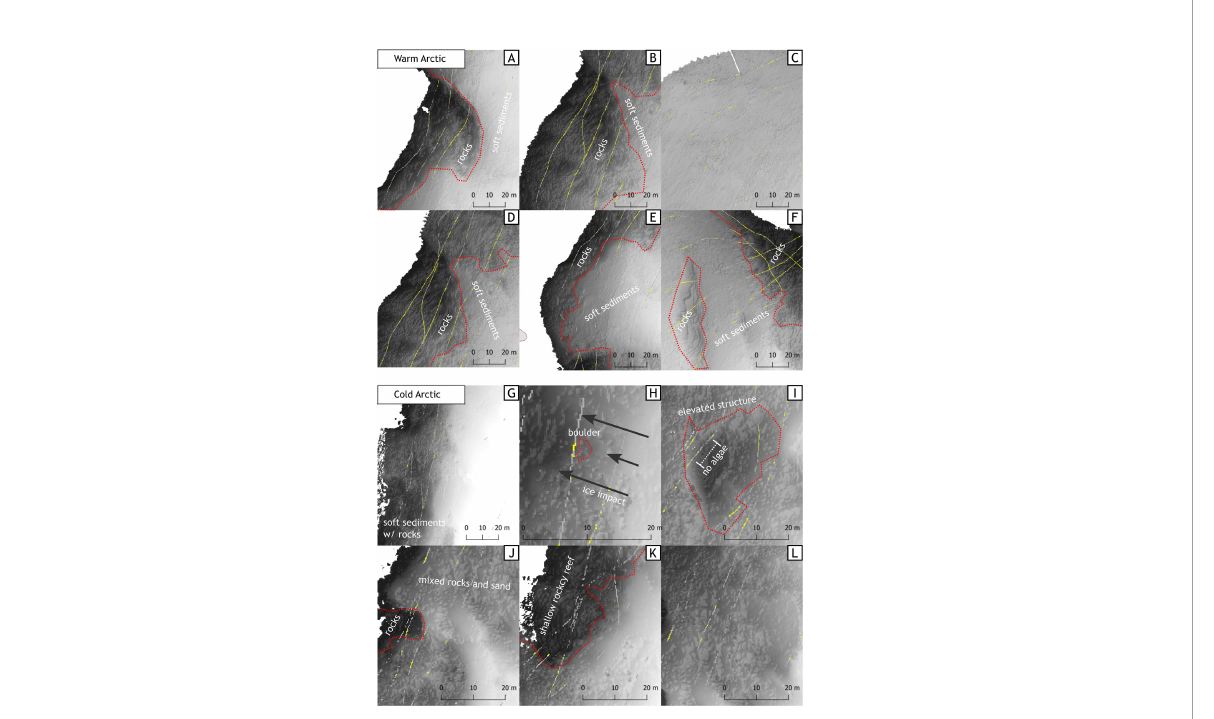
TABLE 5 List of taxa observed on video records. Cold Arctic (Agardhbukta) Warm Arctic (Bohemanesset) Depth of observation Depth of observation Taxon\depth min